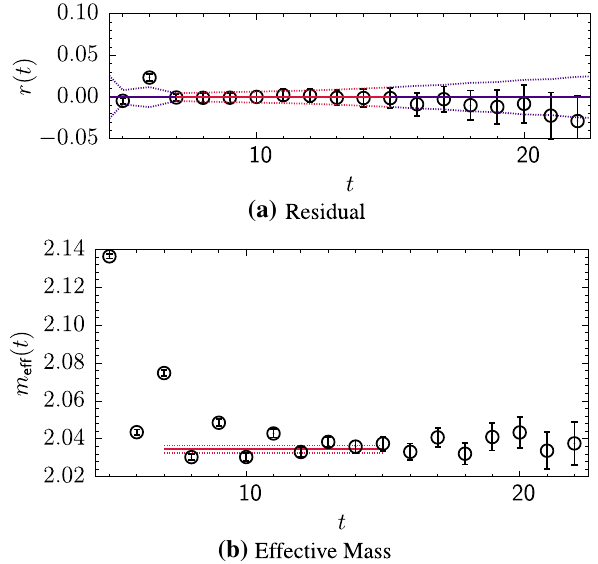
Fig. 1 Correlated fit results for a pseudoscalar heavy–light meson cor- relatorgeneratedwiththeOKactionat κ = 0 . 041and p = 0 . a Residual defined in Eq. (29) and its statistical error from a fit over 7 ≤ t ≤ 15; the kinks for t < 7 are a remnant of the oscillating, wrong-parity states, seen in the right-hand side of Eq. (25). b Effective mass (points) defined in Eq. (28) with fit result for the ground-state energy E (horizontal red line plotted over the chosen fit interval)